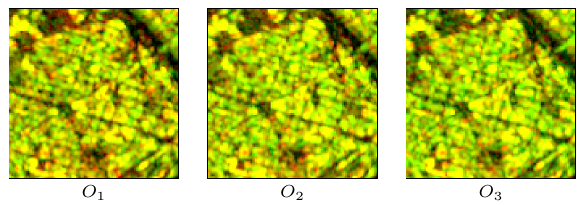
Figure 2. Visual comparison of multiple observations for S1’s VV and VH backscatter Red-Green composition.